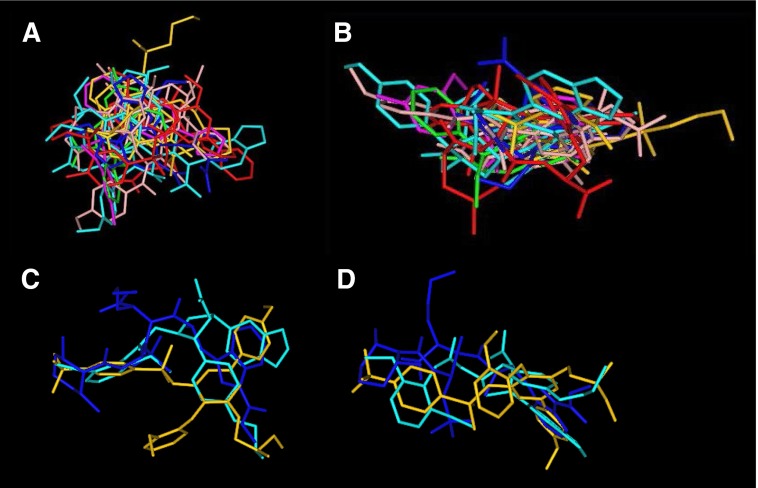
Three-dimensional alignments shown as a top view (A) and the side view (B) of the 11-molecule cluster of ET antagonists using ChemAxon Marvin tool at default settings to perform a flexible overlap of atoms via on-the-fly adjustments. The following 11 were selected as having high affinity: peptide antagonist FR139317 and nonpeptide antagonists, A127722, ambrisentan, avosentan, darusentan, macitentan, PD156707, PD164333, SB234551, sitaxentan, and zibotentan. Top (C) and side view (D) of a three-molecule cluster of ETB peptide antagonist, BQ788, and nonpeptide antagonists A192621 and RO468443.